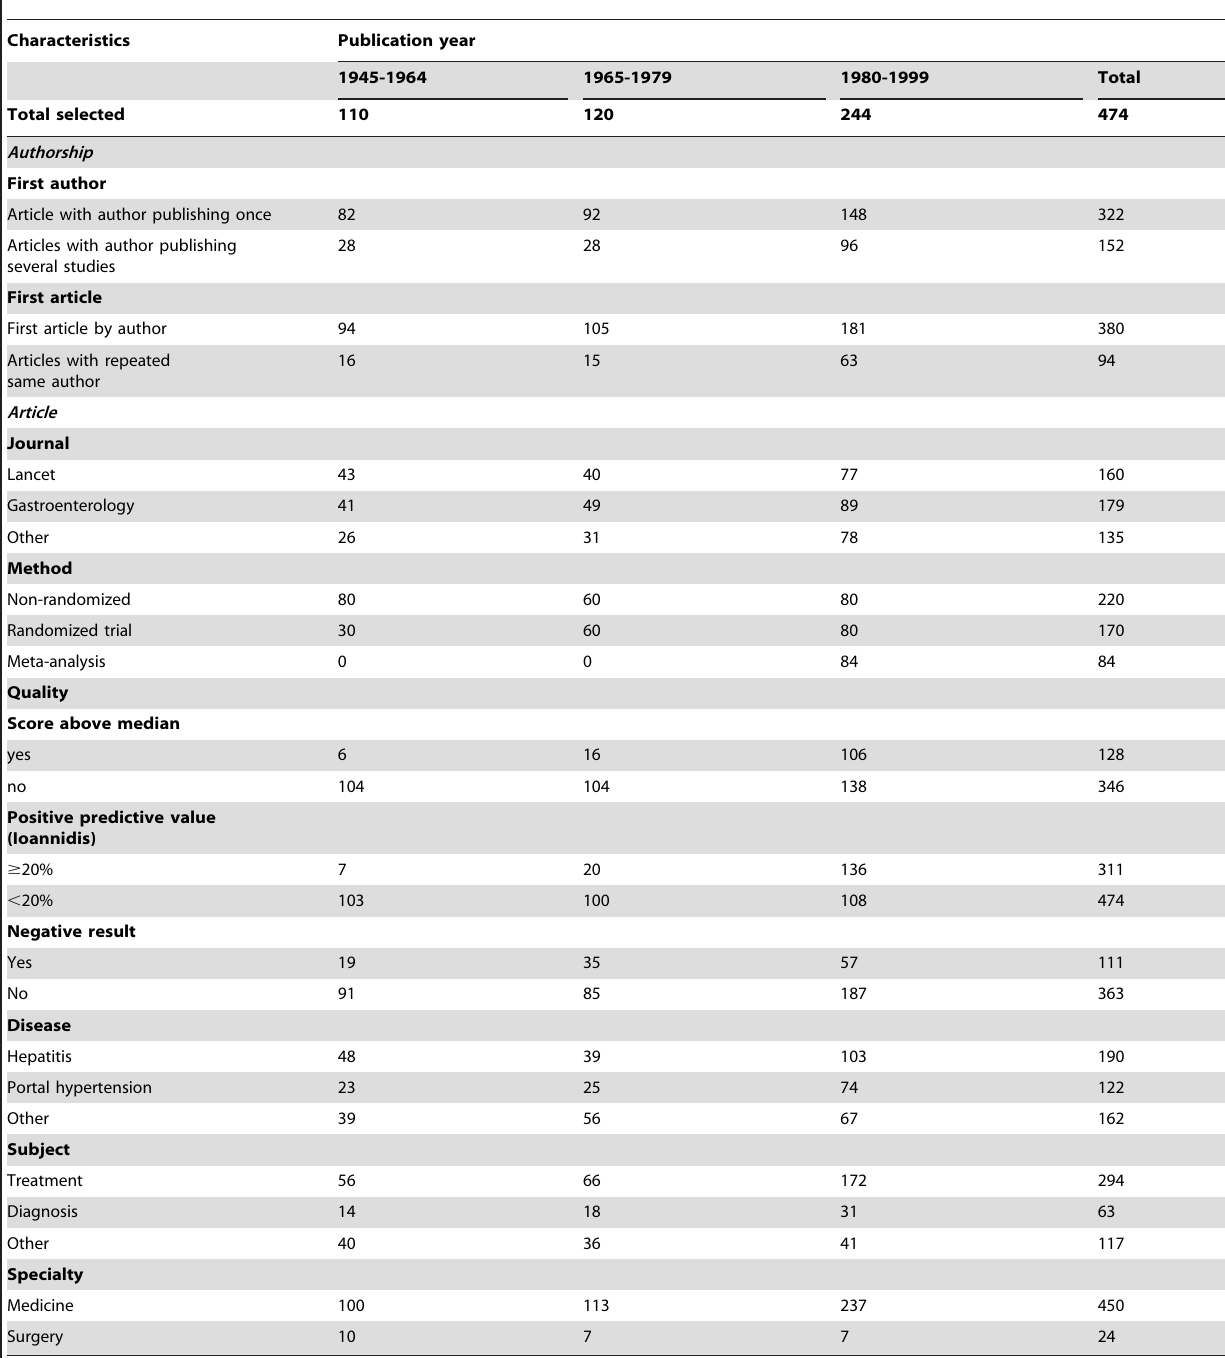
Table 2. Characteristics of included original